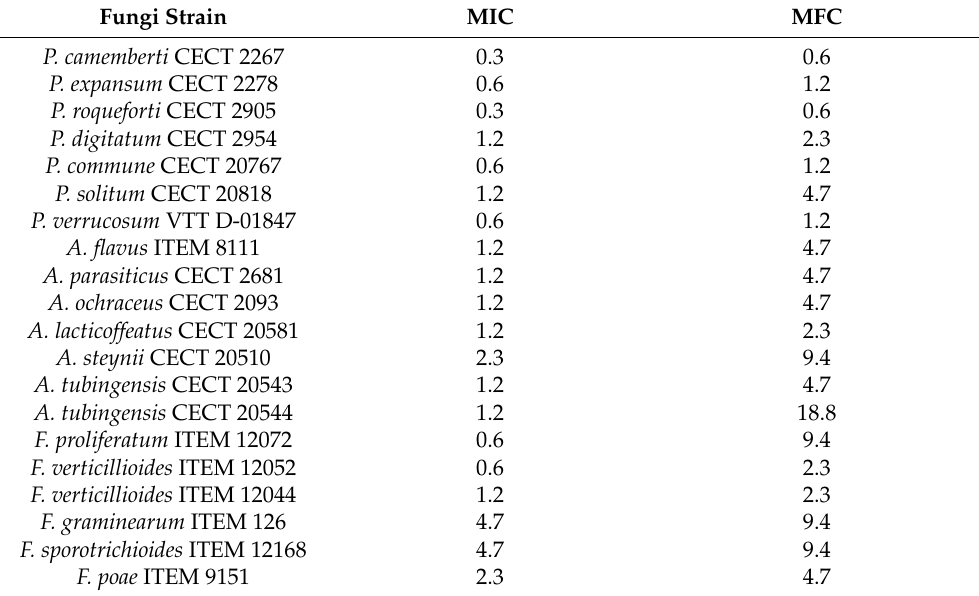
Table 3. Minimum Inhibitory Concentration (MIC) and Minimum Fungicidal Concentration (MFC) of white mustard bran extract (MB) evaluated against Penicillium , Aspergillus , and Fusarium strains. Results are expressed in